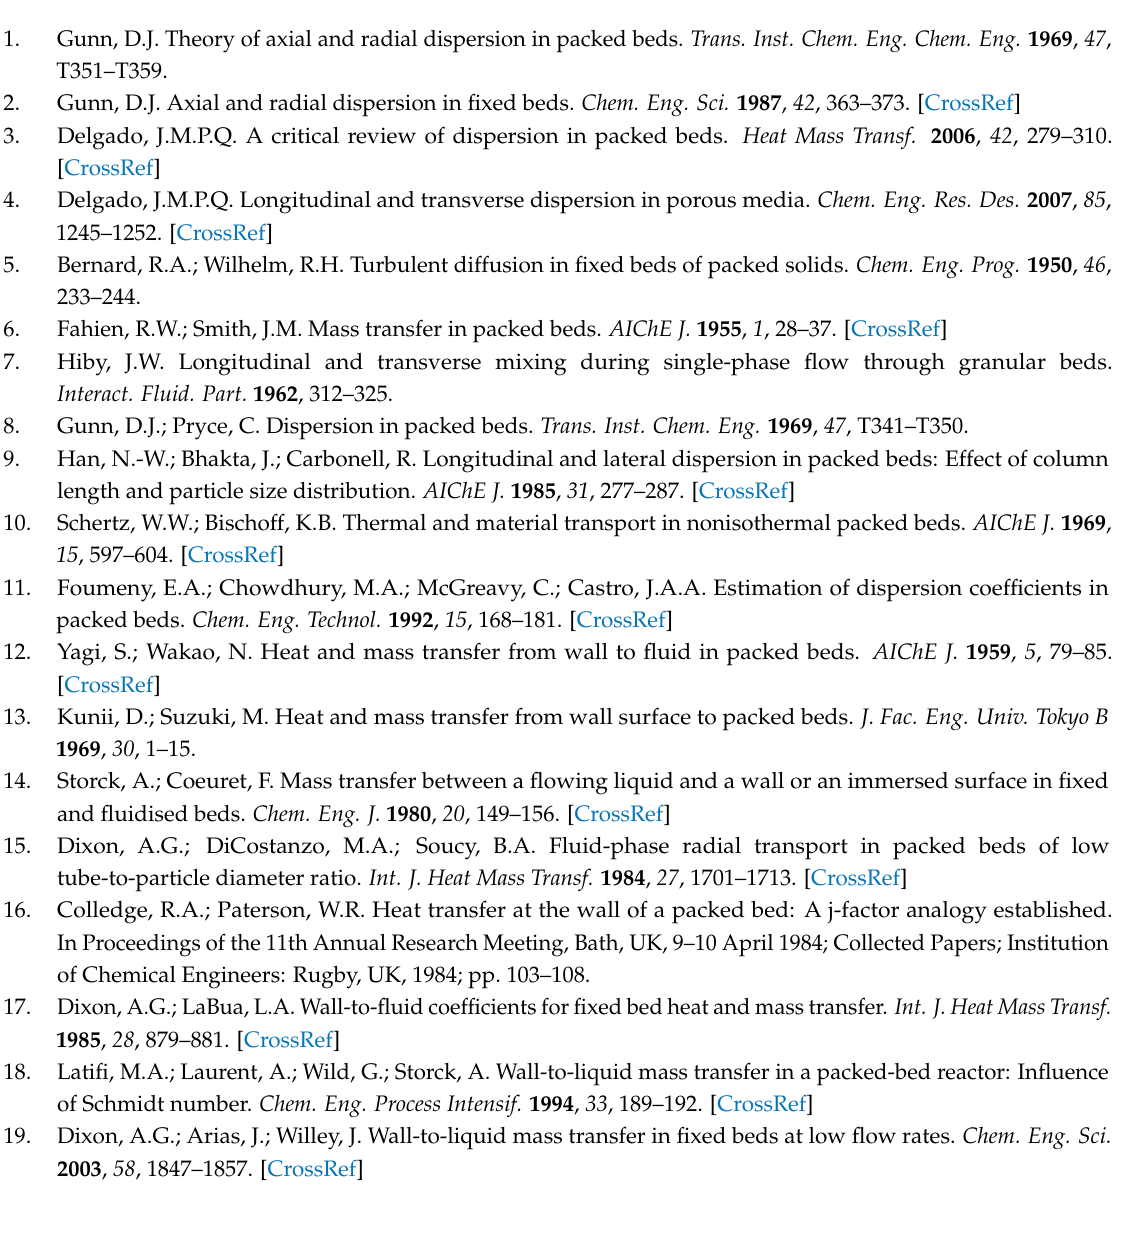
Figure S1: Results for the three-parameter wall function model using D T ( r ) and v z ( r ) for the case N = 5.45; Figure S2: Results for the three-parameter wall function model using D T ( r ) and v z ( r ) for the case N = 5.96; Figure S3: Results for the three-parameter wall function model using D T ( r ) and v z ( r ) for the case N = 6.40; Figure S4: Results for the three-parameter wall function model using D T ( r ) and v z ( r ) for the case N = 7.44; Figure S5: Results for the three-parameter wall function model using D T ( r ) and v z ( r ) for the case N =